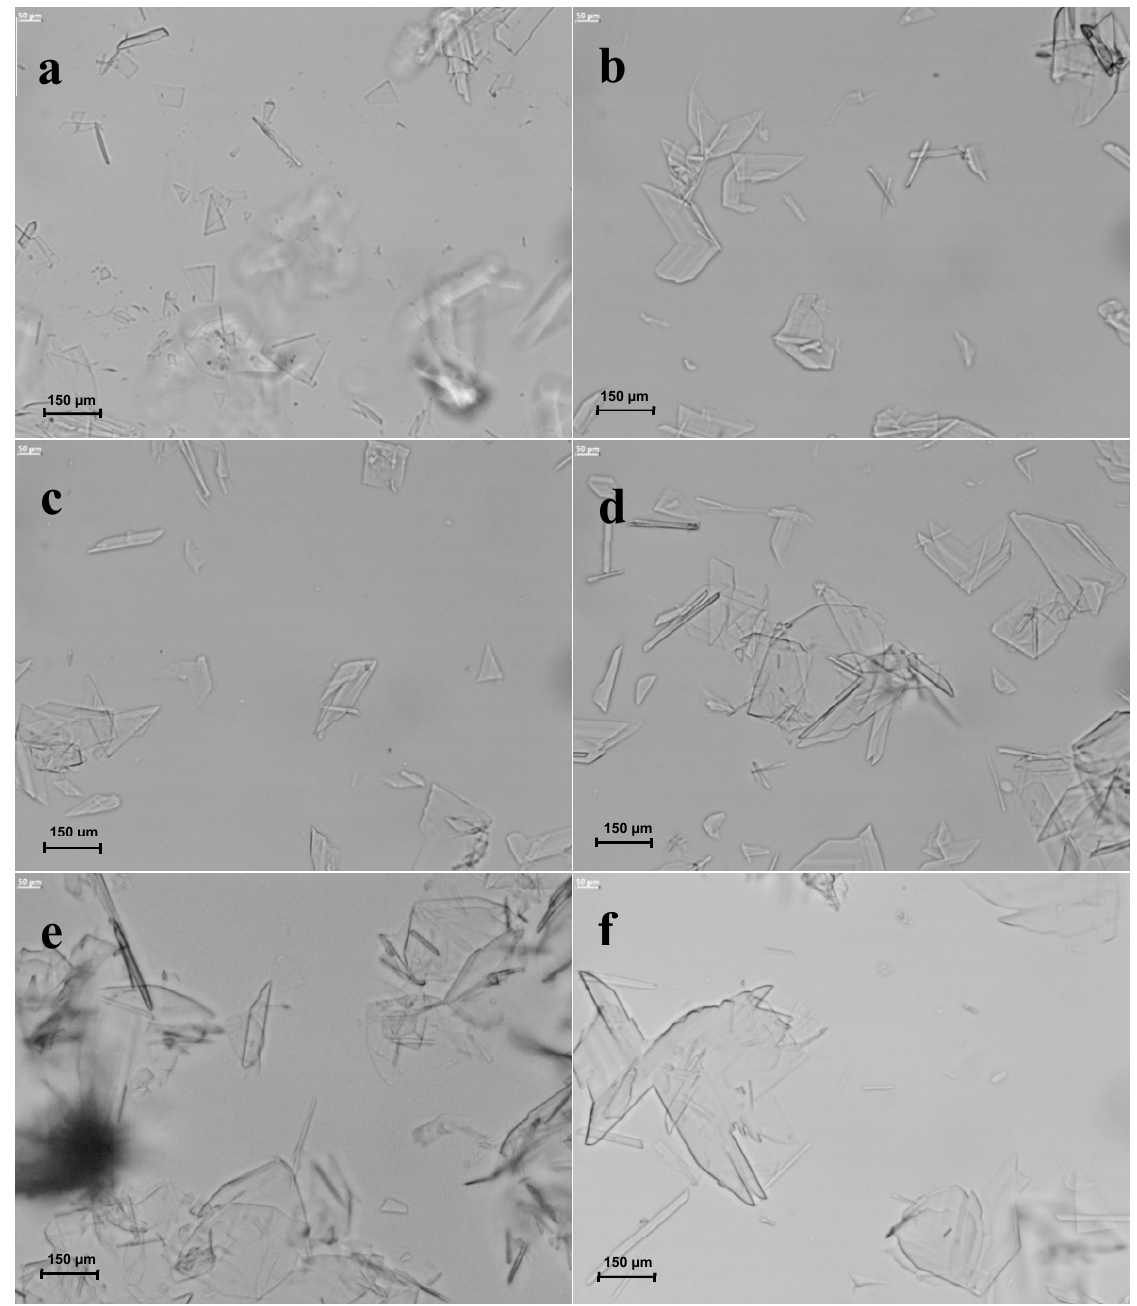
Figure 9. Microscopic photographs (magnification 50 × ) of obtained calcium sulfate dihydrate for C = 0.25 M, n = 1.67 s − 1 and various temperatures: ( a ) T = 298 K; ( b ) T = 303 K; ( c ) T = 308 K; ( d ) T = 313 K; ( e ) T = 318 K; ( f ) T = 323 K.